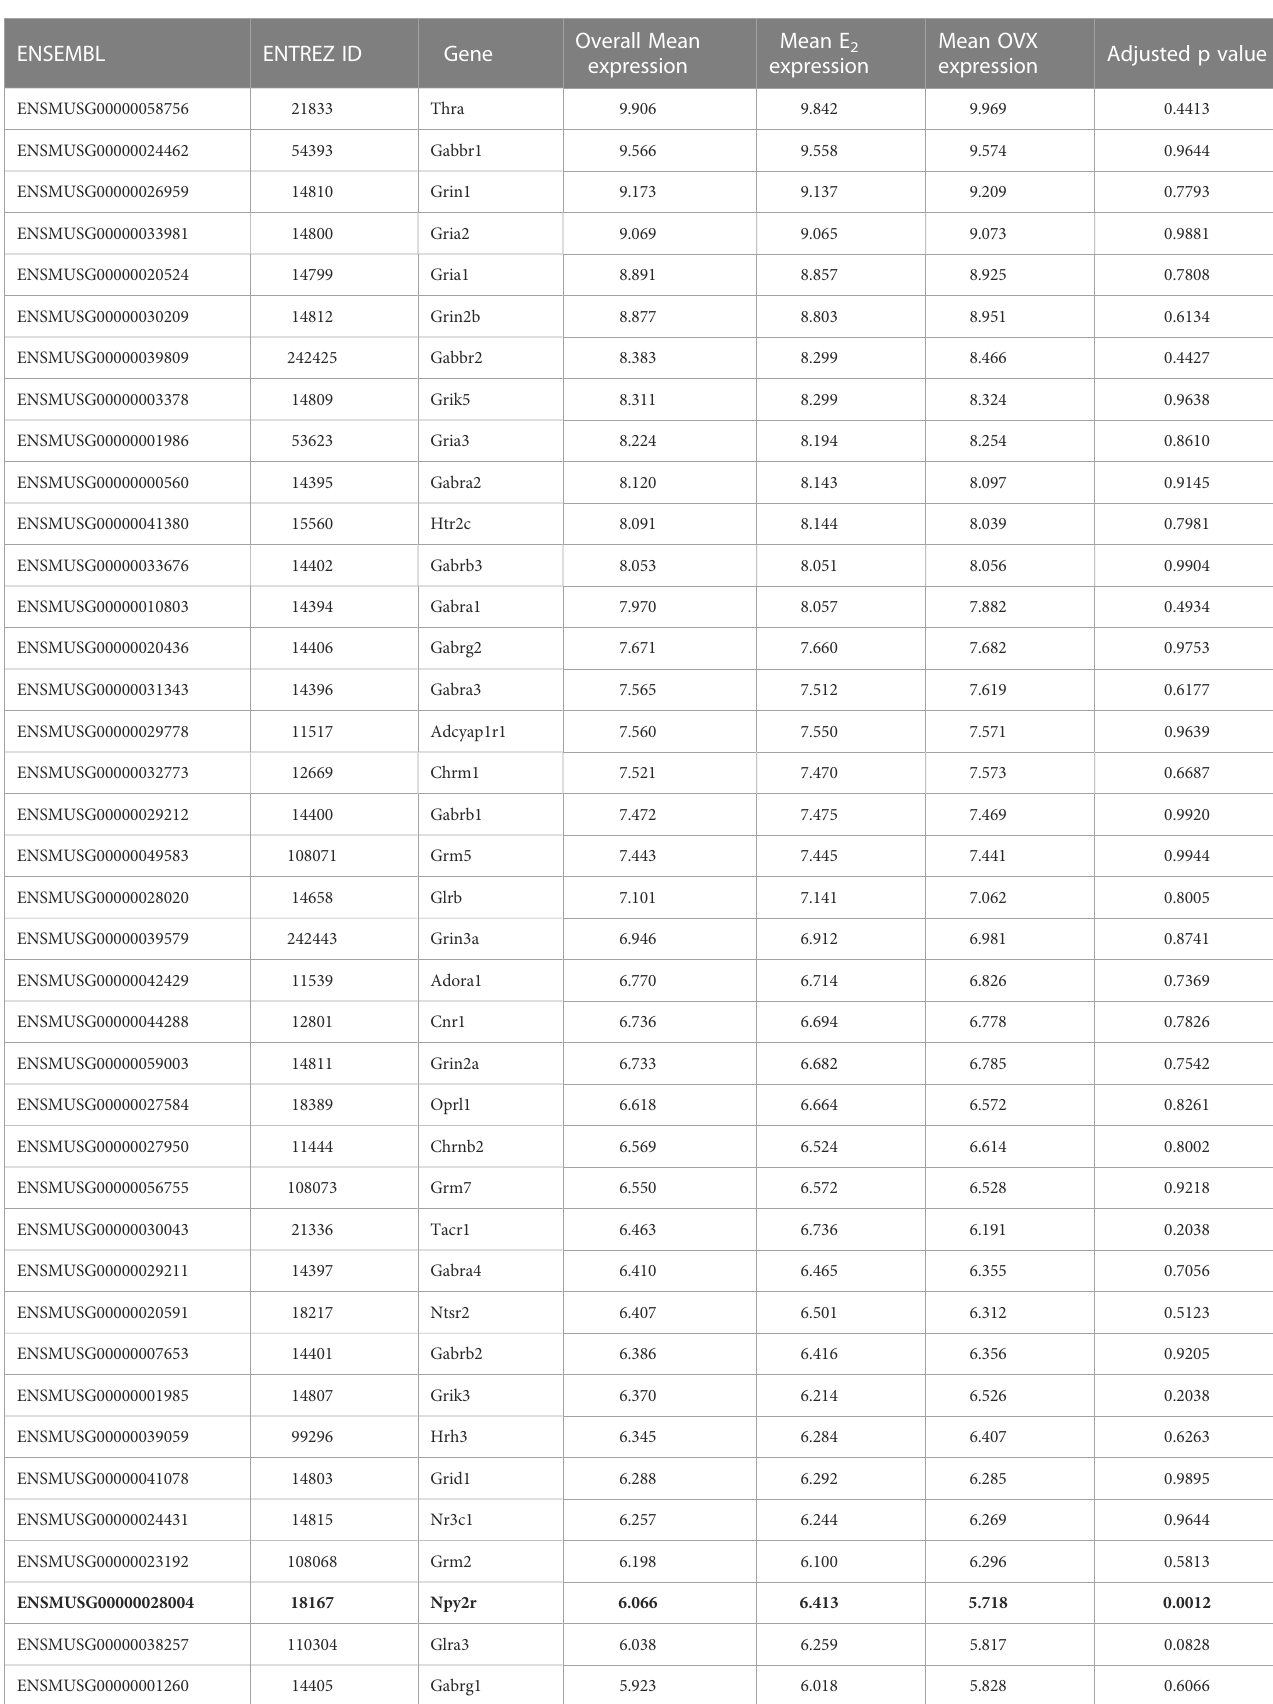
TABLE 3 Notable receptor transcripts identi fi ed in female MeA Kiss1